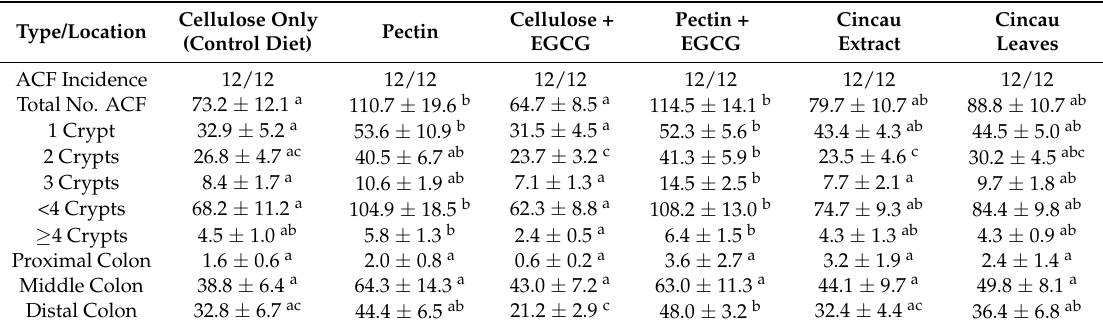
Table 2. Effects of different diets on formation of aberrant crypt foci (ACF) in rat colon six weeks after AOM injections (2 × 15 mg/kg) ( n = 12).